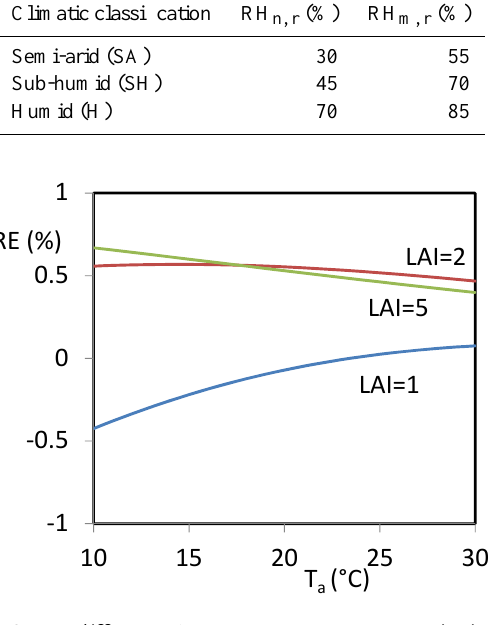
Figure 3. For different LAI, RE on crop evapotranspiration ET c when it is calculated with the modified Penman–Monteith equa- tion (Eq. 10) compared to the two-layer model used as a refer- ence: z h = 1.5m, r s, s = r s, l = 100ms − 1 , under sub-humid